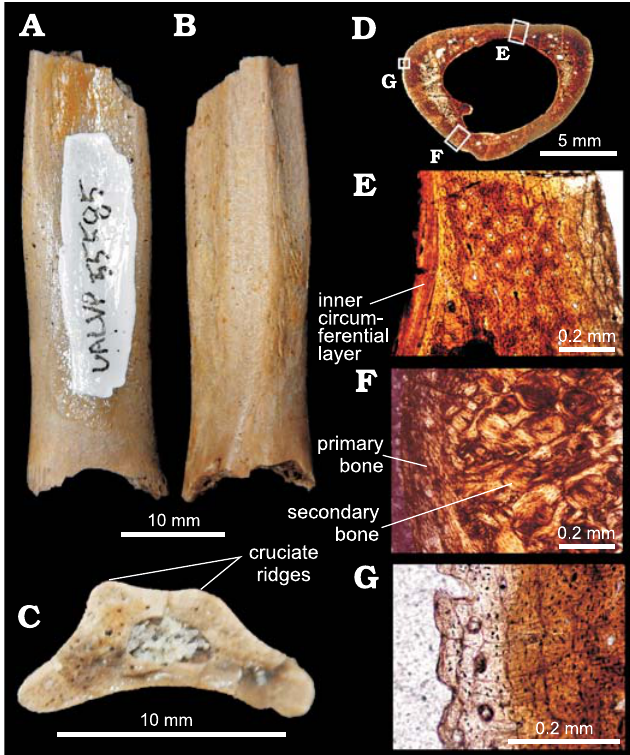
Fig. 9. Elmisaurine dinosaur Leptorhynchos elegans (Parks, 1933) (UALVP 55585) from the Upper Campanian Dinosaur Park Formation, Dinosaur Provincial Park, Alberta, Canada. Metatarsal III in anterior ( A ), posterior ( B ), and cross-sectional ( C ) views. D . Full petrographic thin section in proximal cross-sectional view (anterior is up). E – G . Details of D . E . Thin anterior cortex showing development of the inner circumferential layer. F . Posterior cortex showing extent of secondary bone relative to primary bone. G . Anteromedial corner showing localized development of highly vascularized periosteal bone. Images in plane-polarized light (D, E, G) and 90° cross-polarized light